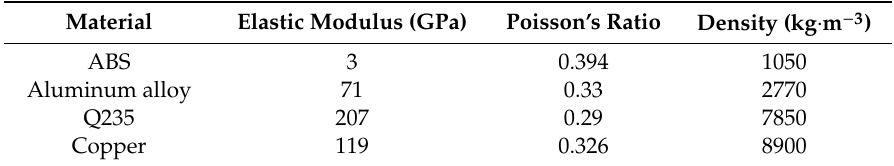
Table 1. Material properties of the FDM color 3D printer.